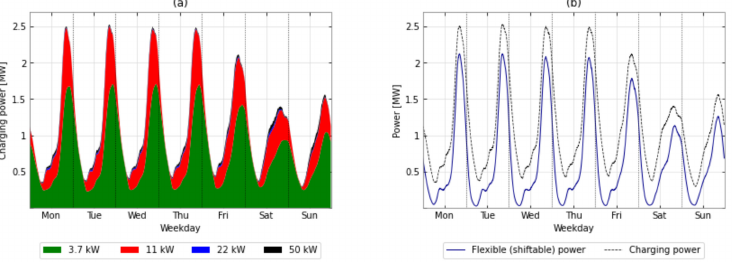
Figure A11. ( a ) User Group A: Charging power profile as a function of the assumed charging power used; ( b ) User Group A: Relation between the charging power profile and the associated flexible (shiftable) power.